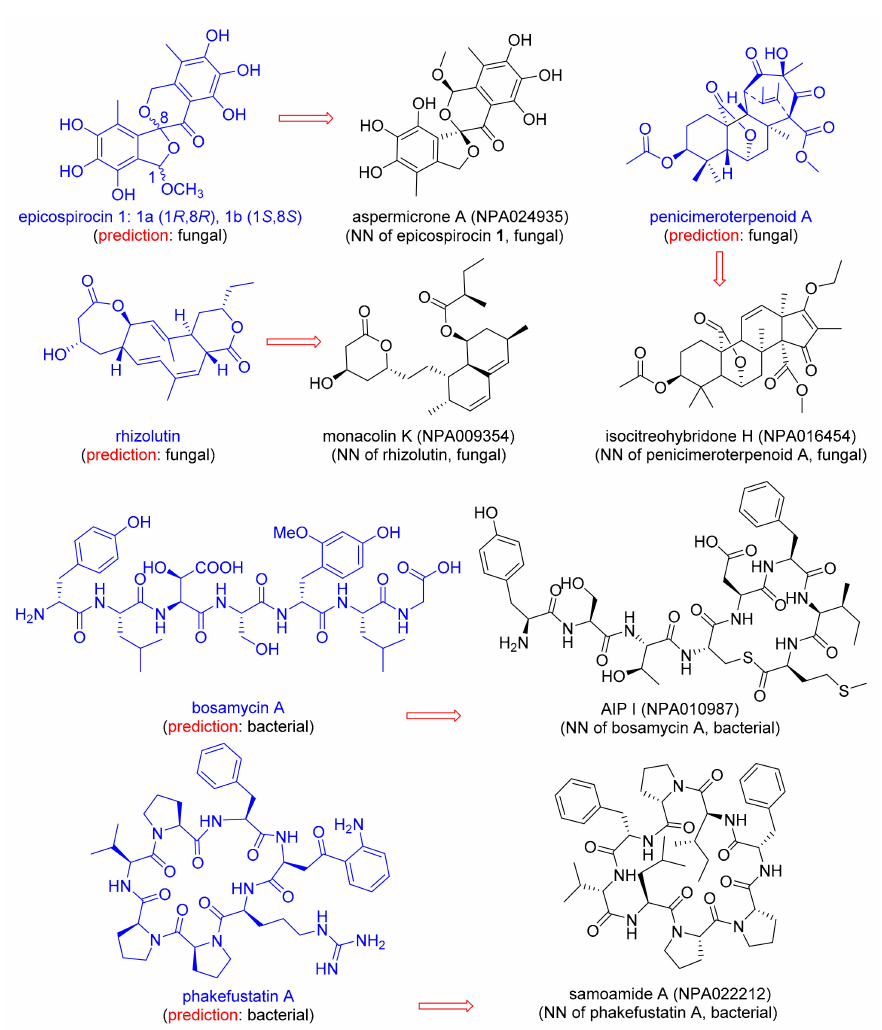
Figure 3. Examples of natural products reported in 2020, absent from NPAtlas, annotated with their predicted origin, and connected to its MAP4 NN in the training set.